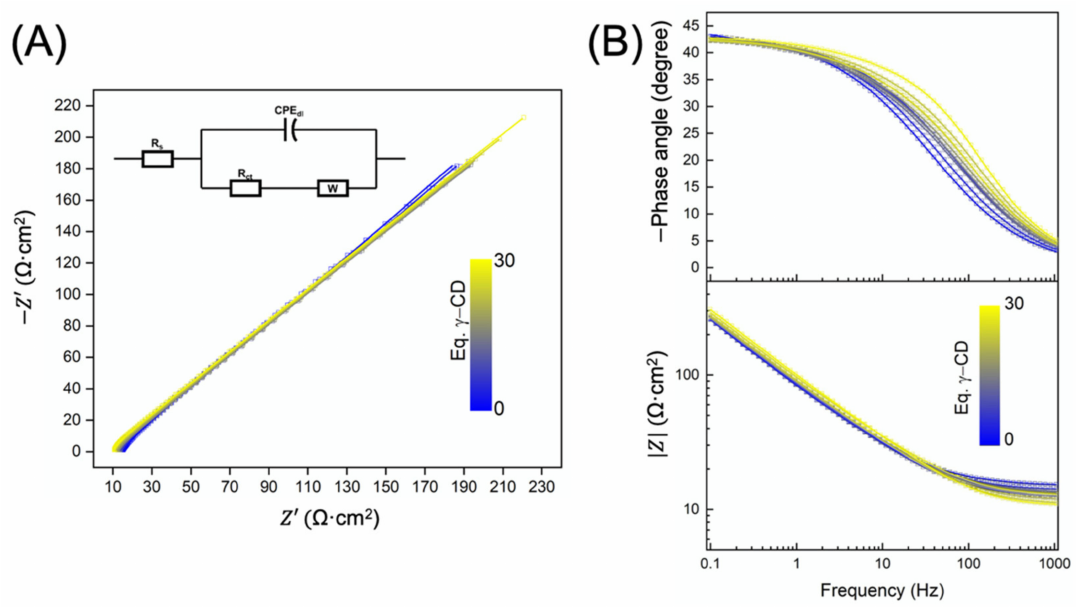
Figure 5. ( A ) Nyquist diagram and ( B ) Bode diagram of the NaP 5 W 30 anion (1 mmol · L − 1 , glassy carbon working electrode) in the presence of increasing amounts of γ -CD (from 0 to 30 equivalents). The experiments were performed at − 0.29 V vs. Ag/AgCl in 50:50 ( v:v ) HCl (0.1 mol · L − 1 ):NaCl (0.9 mol · L − 1 ) aqueous solution.